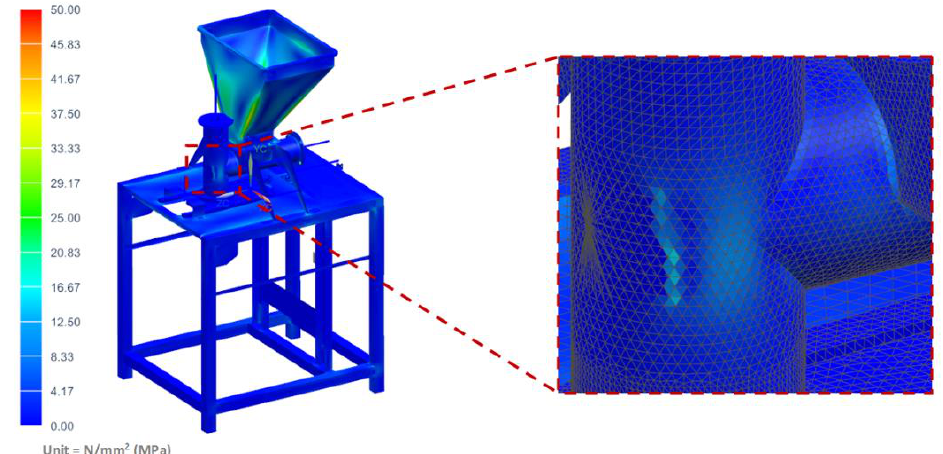
Figure 13. H–M–H stress map of the molding module: pusher of the horizontal dispenser is blocked.